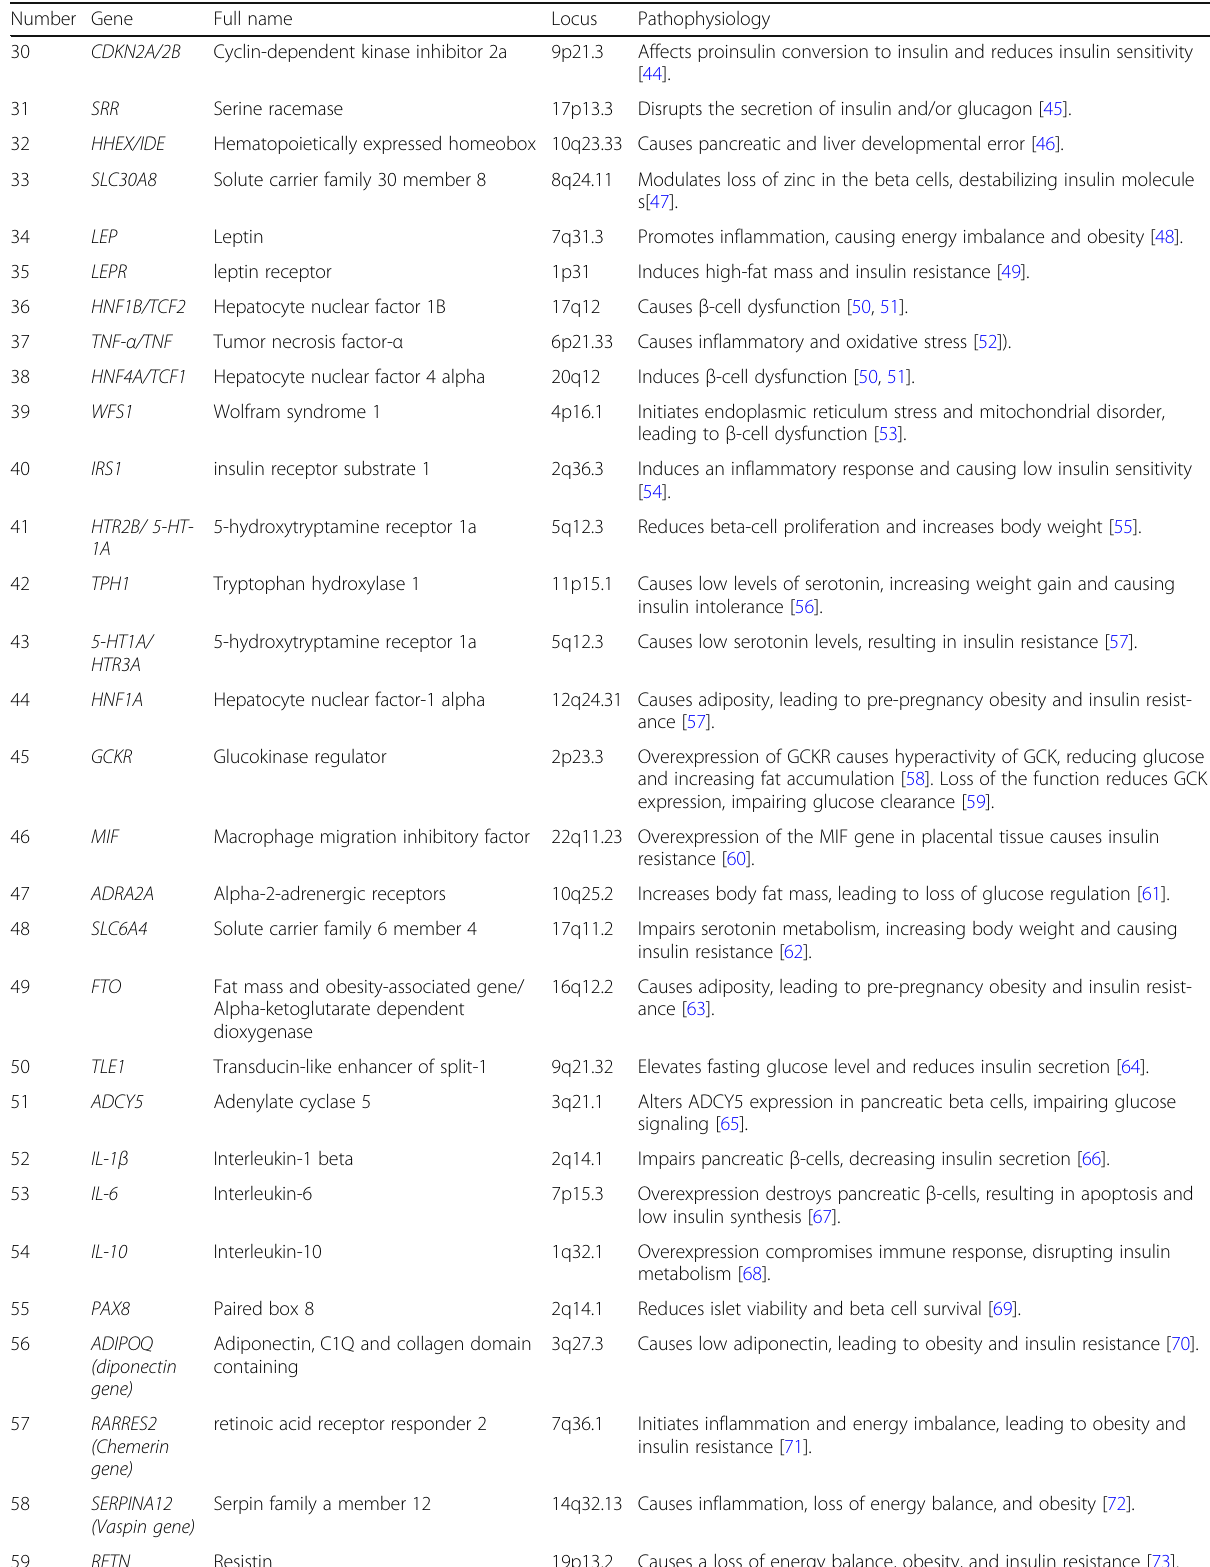
Table 1 GDM predisposing genes showing locations and phathophysiology